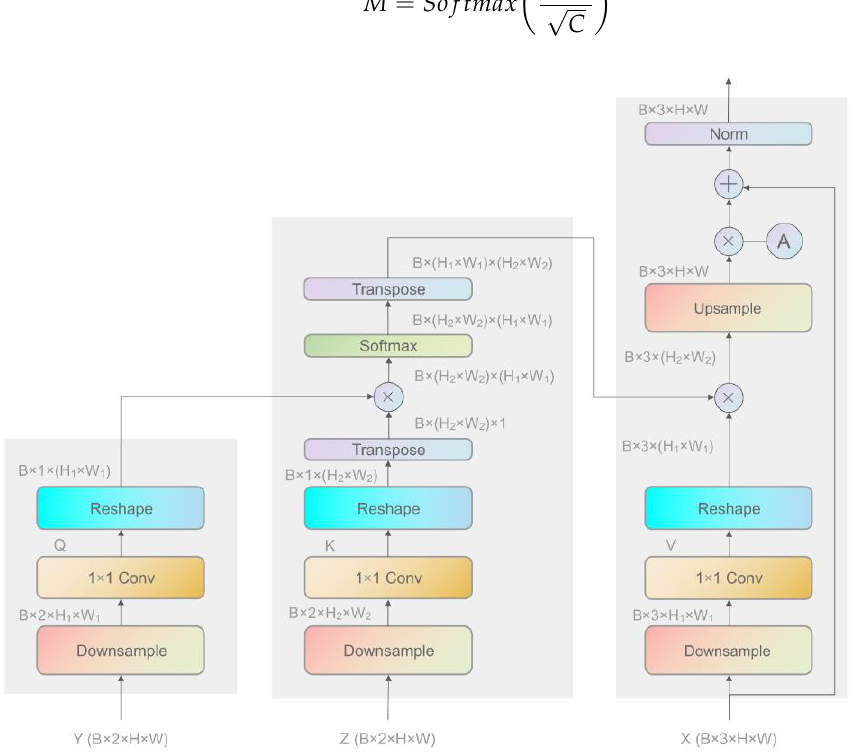
Figure 8. The architecture of the temporal co-attention header.